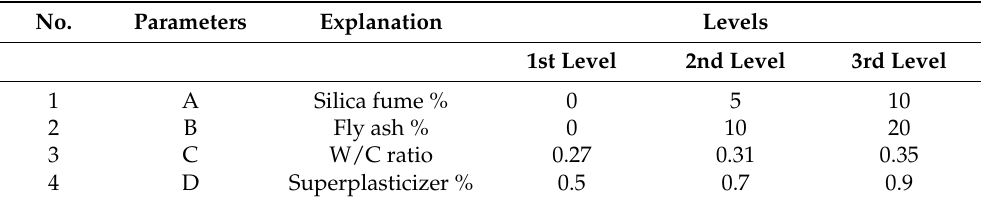
Table 1. Factors and their levels.